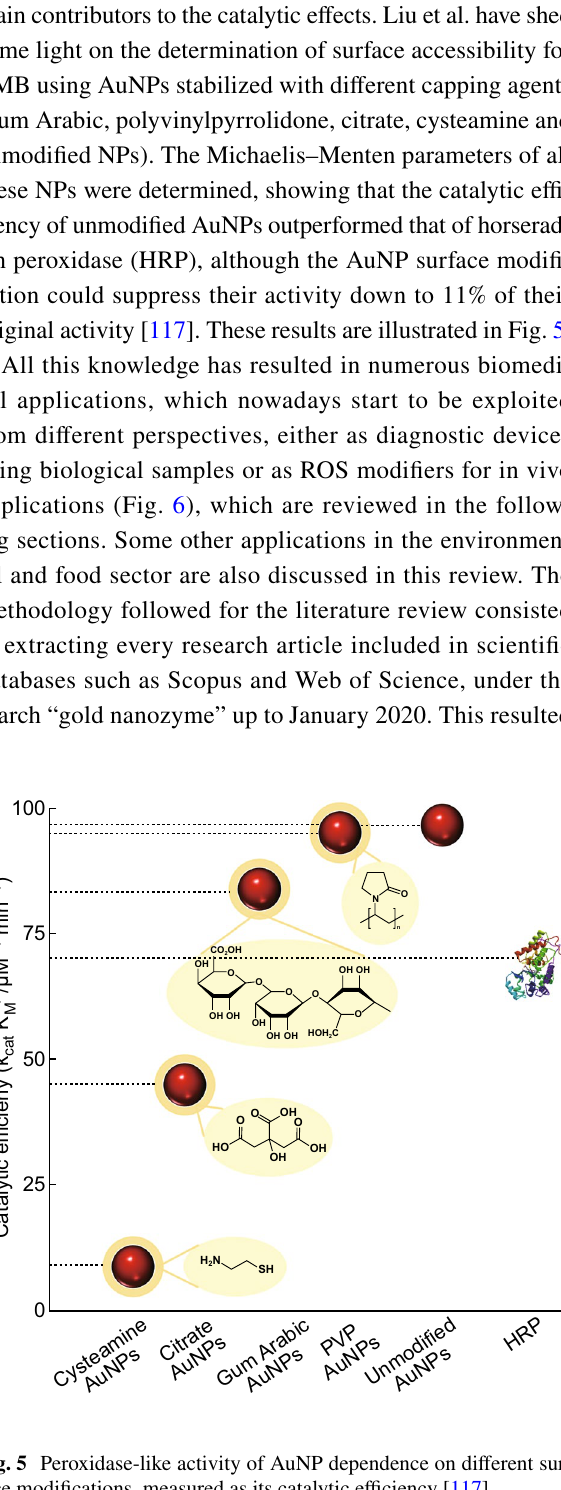
Fig. 5 Peroxidase‑like activity of AuNP dependence on different sur‑ face modifications, measured as its catalytic efficiency